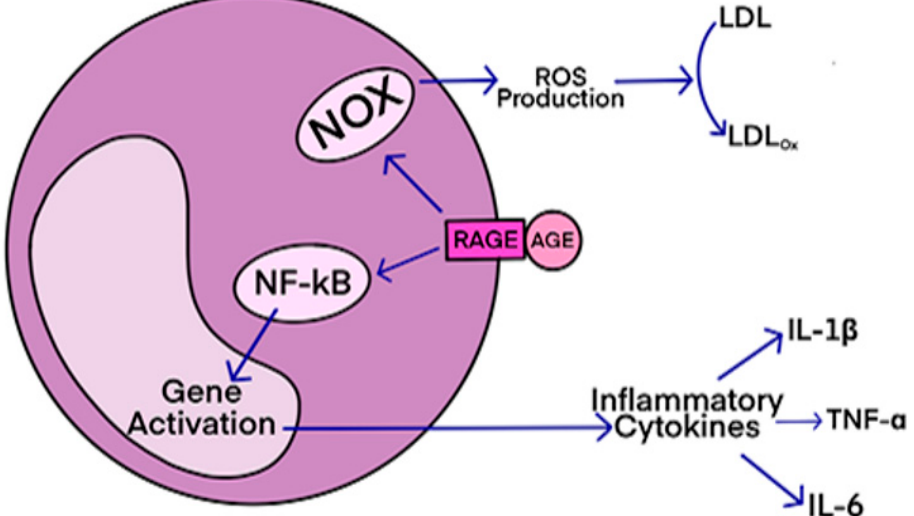
Figure 3. Schematic diagram showing the oxidative stress induced by AGE–RAGE binding interac- tions; The binding of AGEs to RAGE would lead to: (1) activation of NADPH oxidase (NOX), which translates to overproduction of ROS and thereby oxidative damage to cellular components, including low-density lipids, proteins, and nucleic acids; (2) Activation of nuclear transcription factor NF- κβ , and subsequent expression of pro-inflammatory cytokines: IL-1 β , IL-6, and TNF- α .